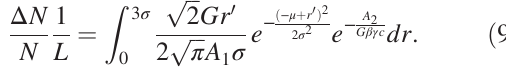
FIG. 10. Points of intersecting Lorentz and intrabeam stripping levels as a function of beam energy and average transverse Twiss parameter h β i , using the same lattice structure and optimization routine as Fig. 8. The solid line shows an exponential fit reflecting Eq. (10). The color bar shows the power loss at each point. The Twiss h β i dependence is used as an emittance-independent measure of beam size for a smoother curve